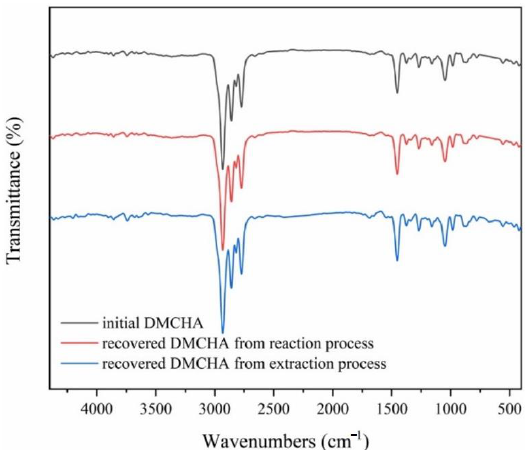
Figure 14. FTIR spectra of initial DMCHA and recovered DMCHA. Reprinted with permission from ref. [45].